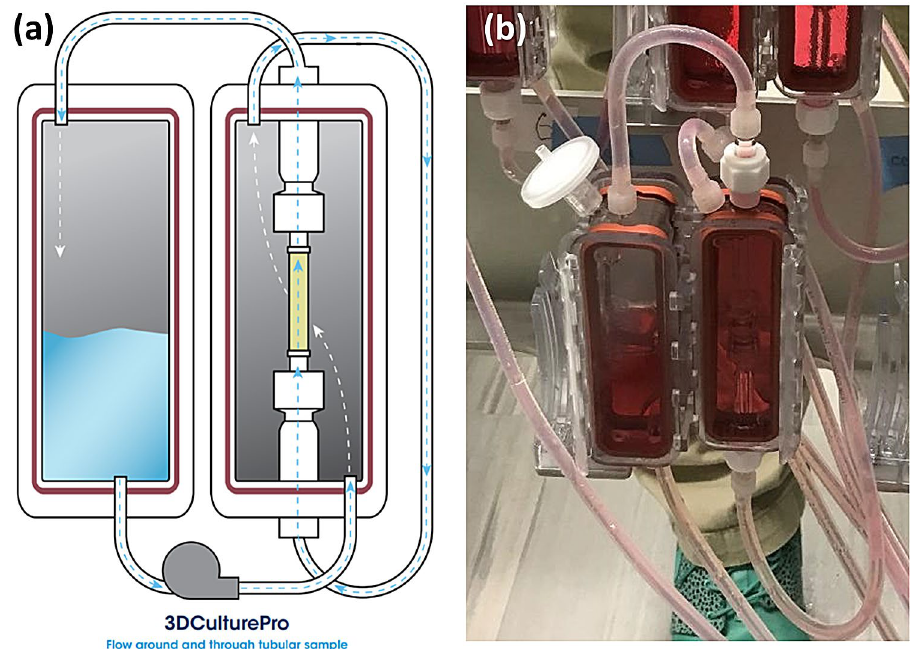
Fig. 2 a A diagram show- ing the path of media flow through the 3DCulturePro ™ perfusion bioreactor, and b the assembled bioreactor with a scaffold clamped